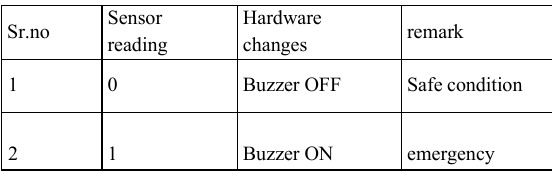
Table 4: result analysis of smart